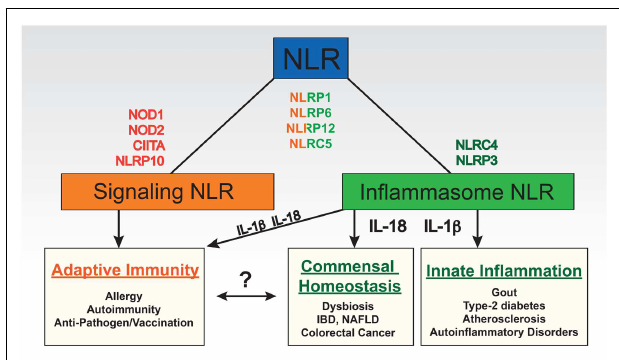
FIGURE 1 | Functional categories of NLRs based on their roles in shaping immune responses . Some NLRs have been found to play primary roles in regulating particular pathways (e.g., transcription) or signaling cascades (“signaling NLRs”) such as NOD1, NOD2, NLRP10 (putative signaling NLR), and CIITA. Others regulate the formation of inflammasomes (“inflammasome NLRs”) such as NLRP3 and NLRC4. Some do both such as NLRP1, NLRC5, NLRP6, and NLRP12.The immune consequences of these broad categories can be quite different. Although IL-1 β and IL-18 derived from inflammasome activity can regulate particular aspects of adaptive immunity, direct roles of each of these cytokines in promoting non-lymphocyte based inflammatory reactions or commensal flora in the gut have also been identified.The latter has been implicated in shaping the adaptive immune system and therefore we linked these two categories; however, no direct role has yet been identified for an NLR in this link. On the other hand, NLRs involved in signaling cascades that in particular effect dendritic cell function as antigen presenting cells have a more obvious direct effect on adaptive immunity. IBD, inflammatory bowel disease; NAFLD, non-alcoholic fatty liver disease.